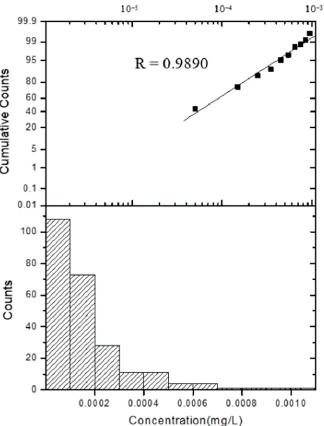
Figure 2. Statistical distribution of detected daily average concentrations of Hg of the WWTPs.